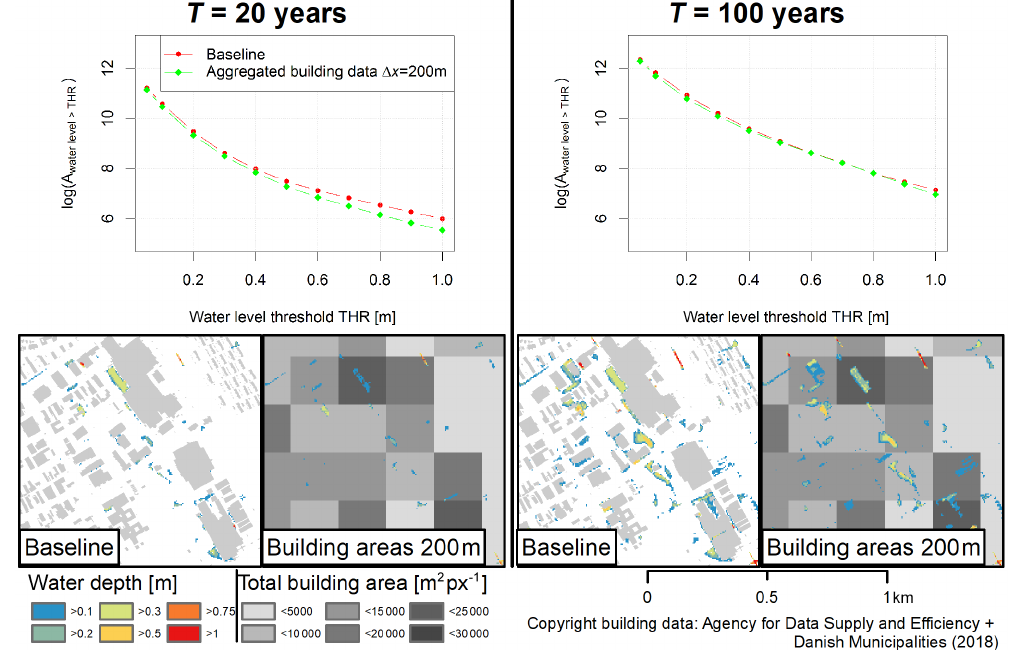
Figure 5. Total area flooded above water level threshold in baseline 2D simulation and in simulation based on building footprint areas aggregated to 200m raster. Results are shown for return periods of 20 (left) and 100 (right) years. Maps below the plots illustrate simulated water depths in the different cases with background showing building footprint polygons (baseline) and total building footprint area per 200m × 200m pixel (aggregate building data). Vector building data are subject to copyright conditions defined in © Agency for Data Supply and Efficiency and Danish Municipalities